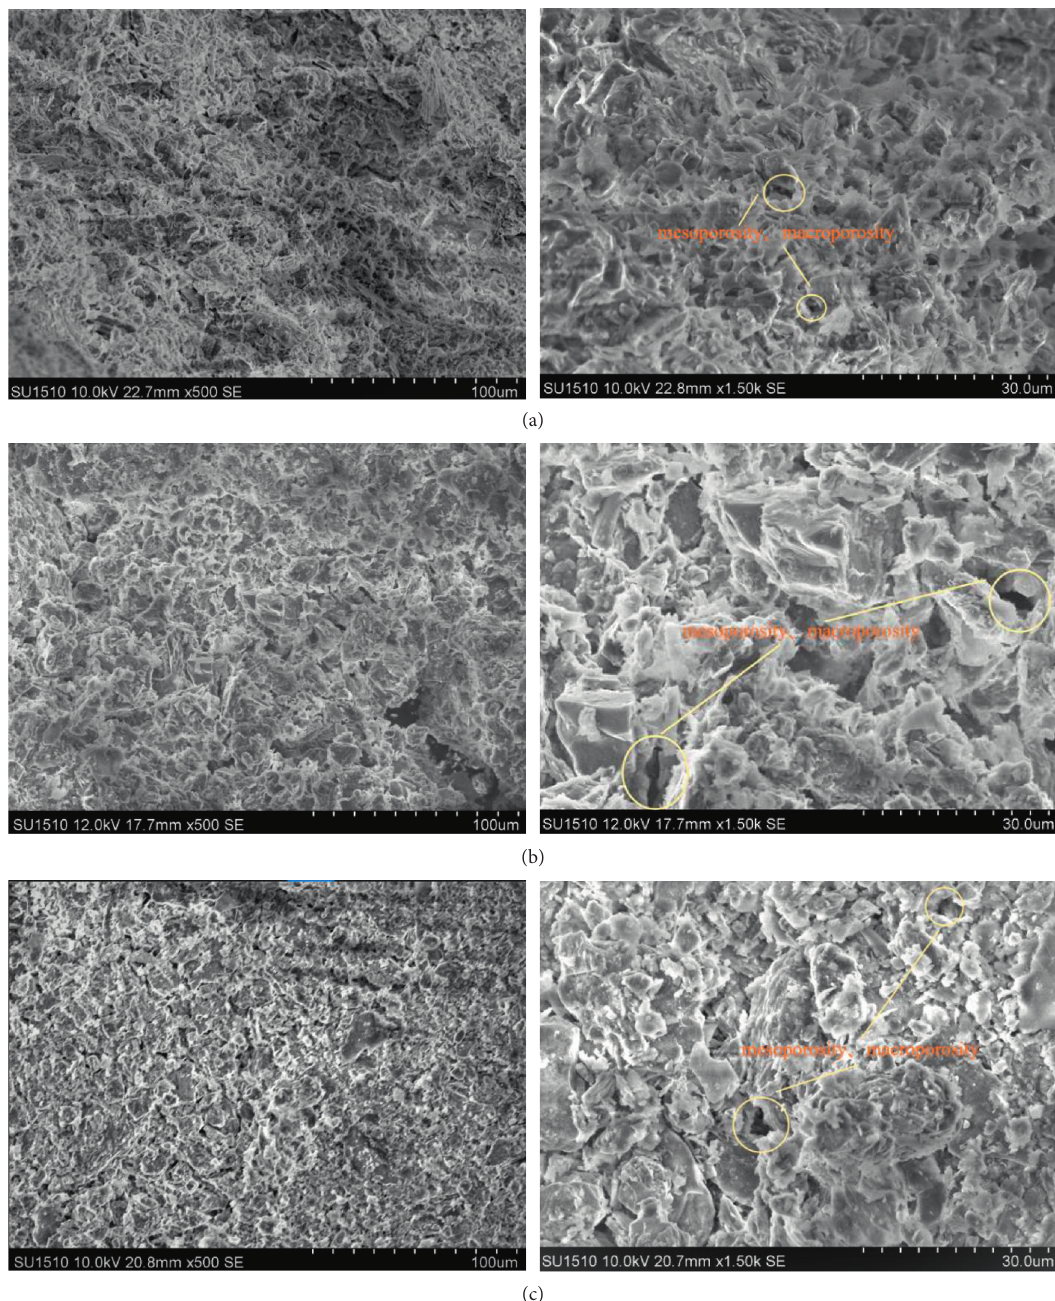
Figure 9: Layer (4) of the change of microstructure by SEM. (a) Uncontaminated clay. (b) The field contaminated clay. (c) Indoor soaked contaminated